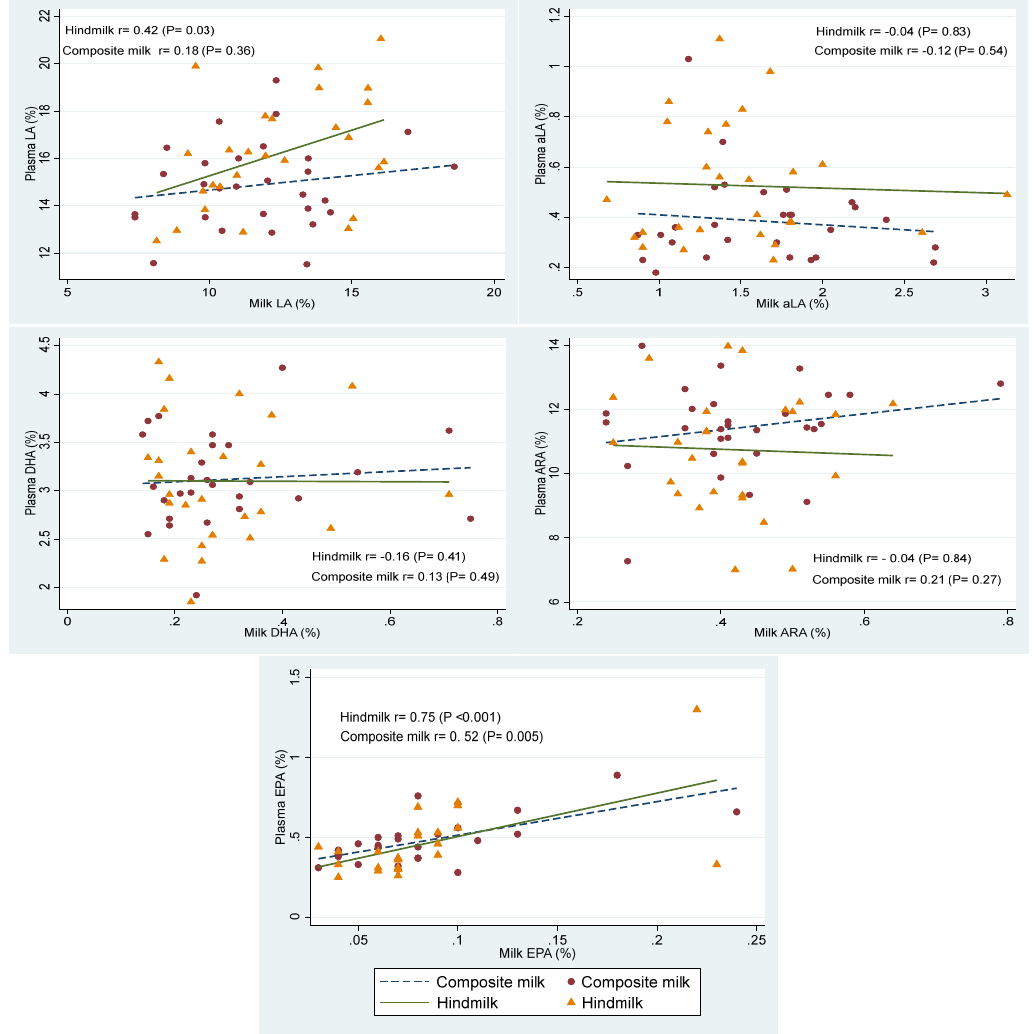
Figure 4. Correlations between milk and plasma bioactive fatty acids.